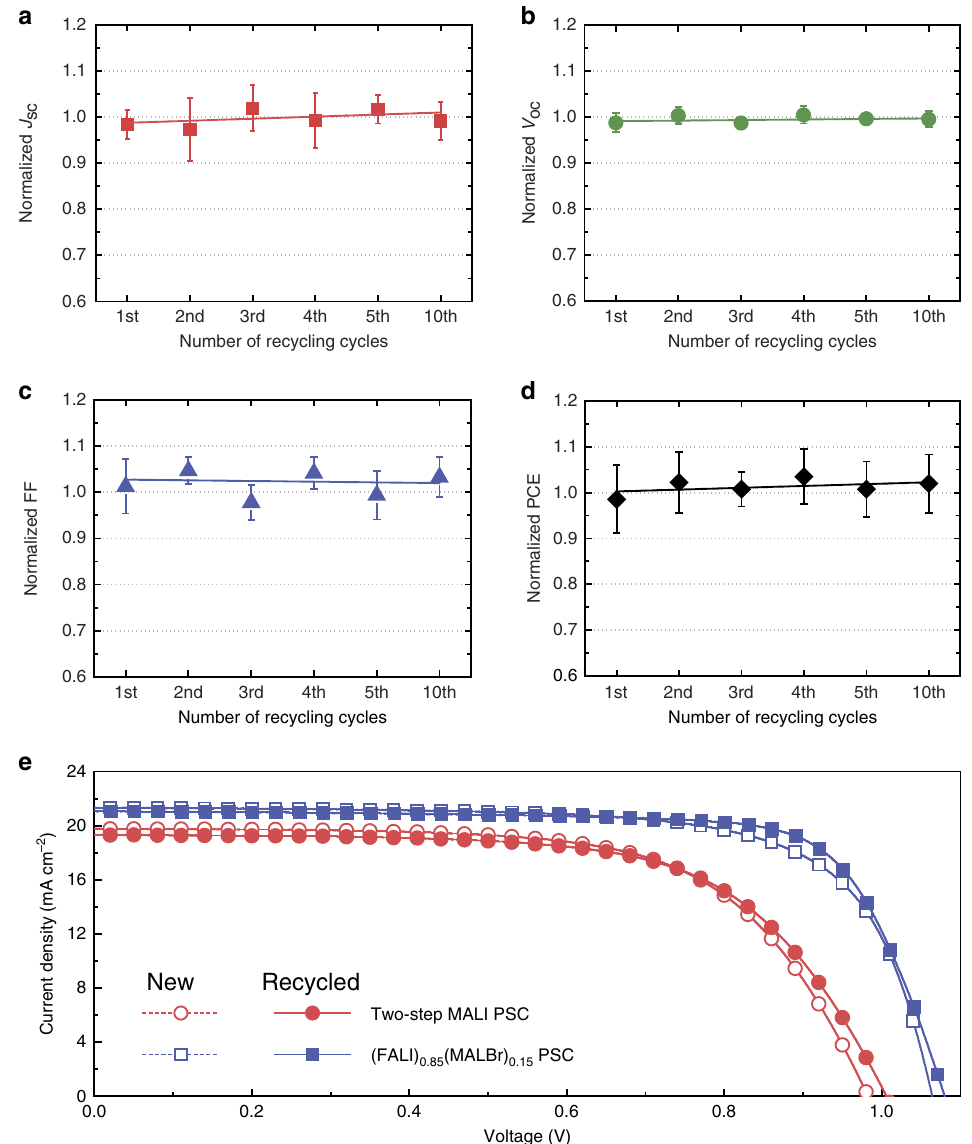
Figure 6 | Photovoltaic performance characteristics of recycled PSCs. Normalized trends in the ( a ) short-circuit current density, ( b ) open-circuit voltage, ( c ) fill factor and ( d ) efficiency of MALI-based PSCs fabricated on 1st-, 2nd-, 3rd-, 4th-, 5th- and 10th-time recycled substrates compared with those of the MALI-PSC fabricated on the newly prepared substrate. ( e ) J–V curves for two-step processed MALI-based PSCs (red spheres) and (FALI) 0.85 (MALBr) 0.15 -based PSCs (blue squares) on new (dotted lines and empty symbols) and once-recycled (solid lines and filled symbols) mp-TiO 2 /TCG substrates. The error bars in a – d indicate the s.d.’s calculated from five